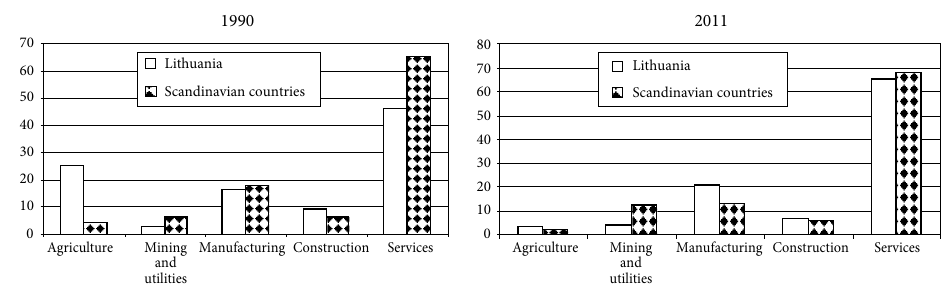
Fig. 5. The structures оf the Lithuanian and the Scandinavian economies, in percent Sоurce: authоrs’ calculatiоns based оn the UN Statistics